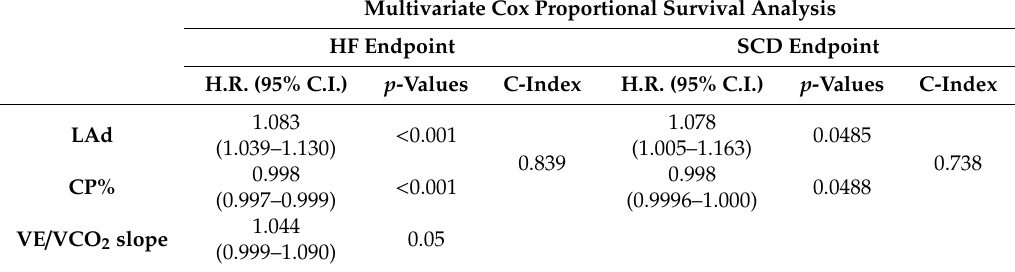
Table 4. Significant multivariate Cox proportional survival analysis and test for proportional hazards assumption for the two study